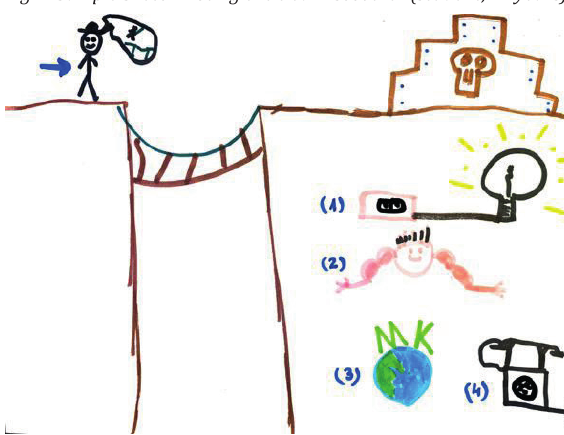
Fig.1. Sample Mind Map: Discoverer (student, 11 years). Fig.2. Sample Sketch-noting entitled Discoverer (student, 11